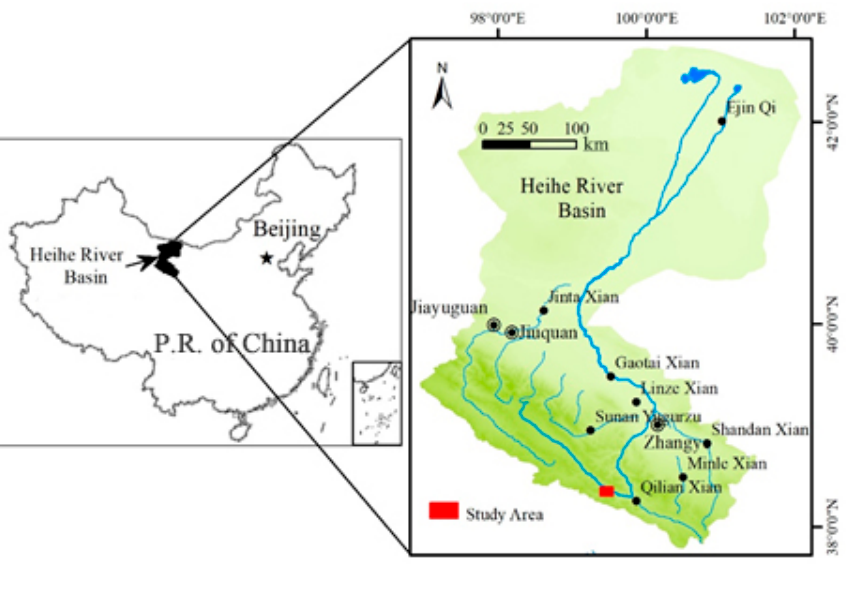
Figure 1. Location of the study area.